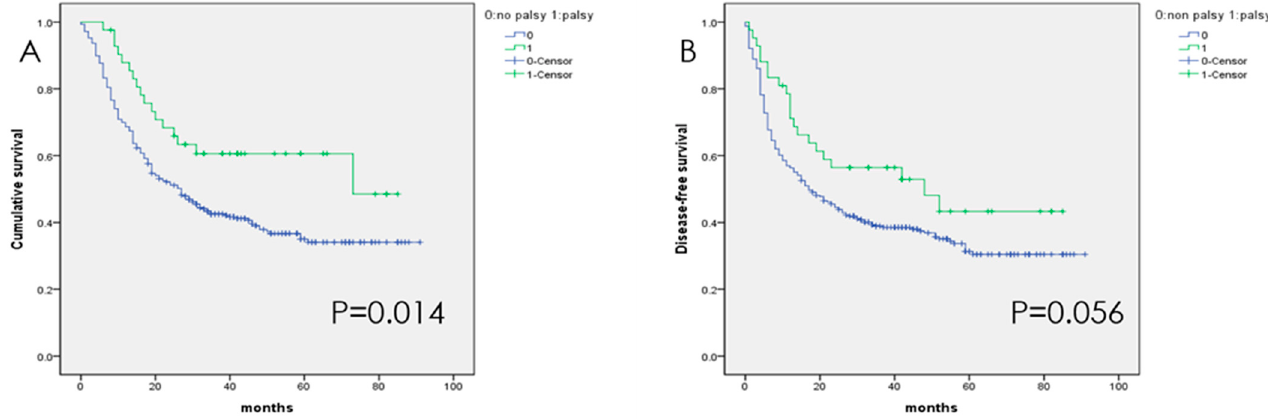
Figure 1. Overall ( A ) and disease-free ( B ) survival of patients after esophagectomy. Patients with unilateral vocal fold paralysis had a significantly better survival rate than those without vocal fold paralysis.